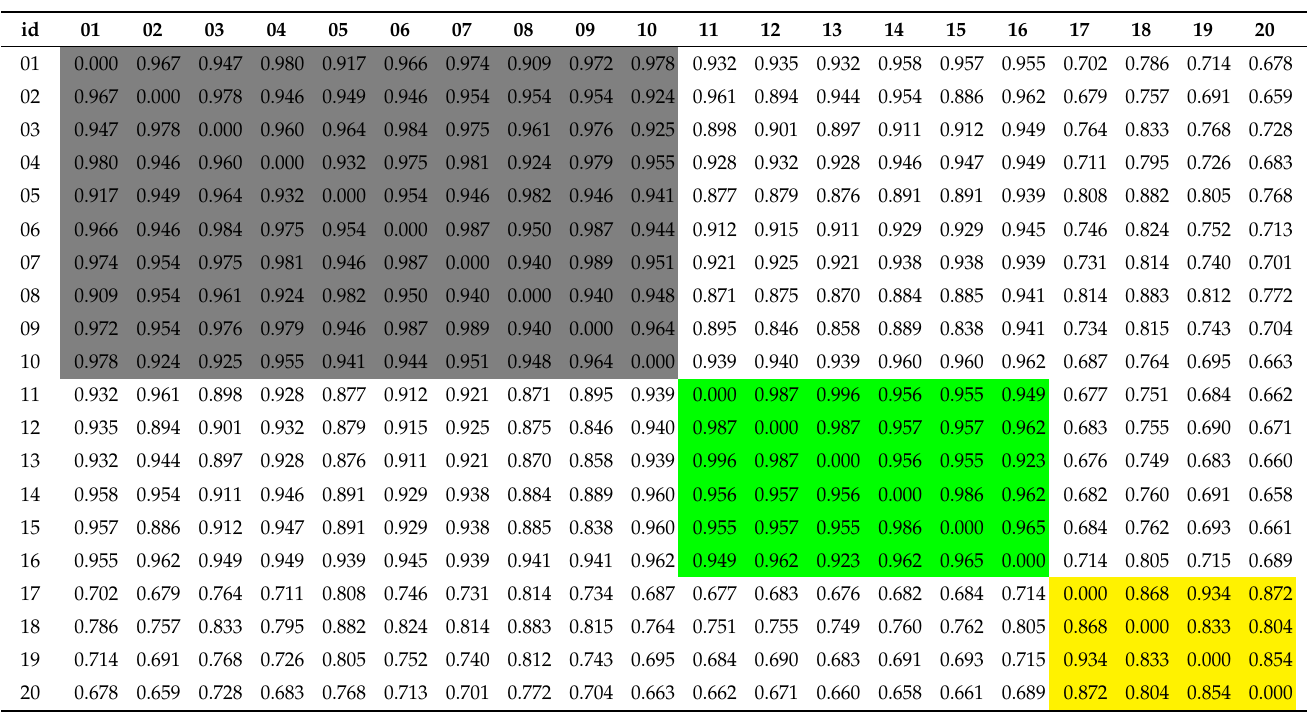
Figure 13. Clustering result based on C-phase voltage sag data. Table 5. The affinity matrix W C of C-phase voltage sag